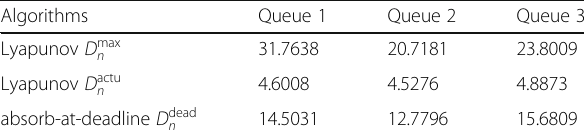
Table 2 Simulation results of two algorithms Algorithms